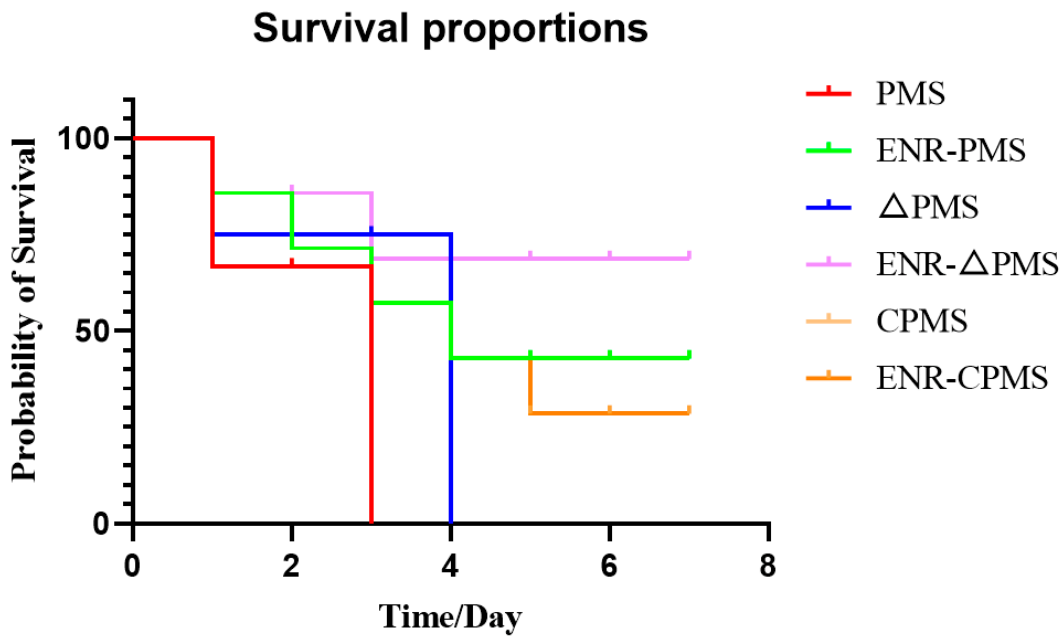
Figure 5. Survival rates of the mice treated with ENR infected by PmS and Δ